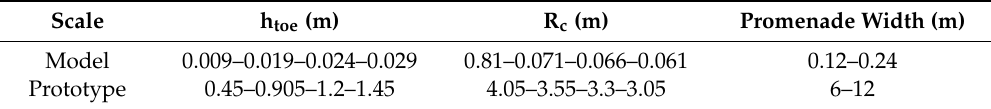
Figure 5. CIEMito wave flume—drawing of the longitudinal section (distorted). Dimensions are in model scale. The value of m is equal to 15 and 30, respectively. Accordingly, n assumes values of 8 and 5, respectively. Table 2. Geometric characteristics of the tested dike layout.